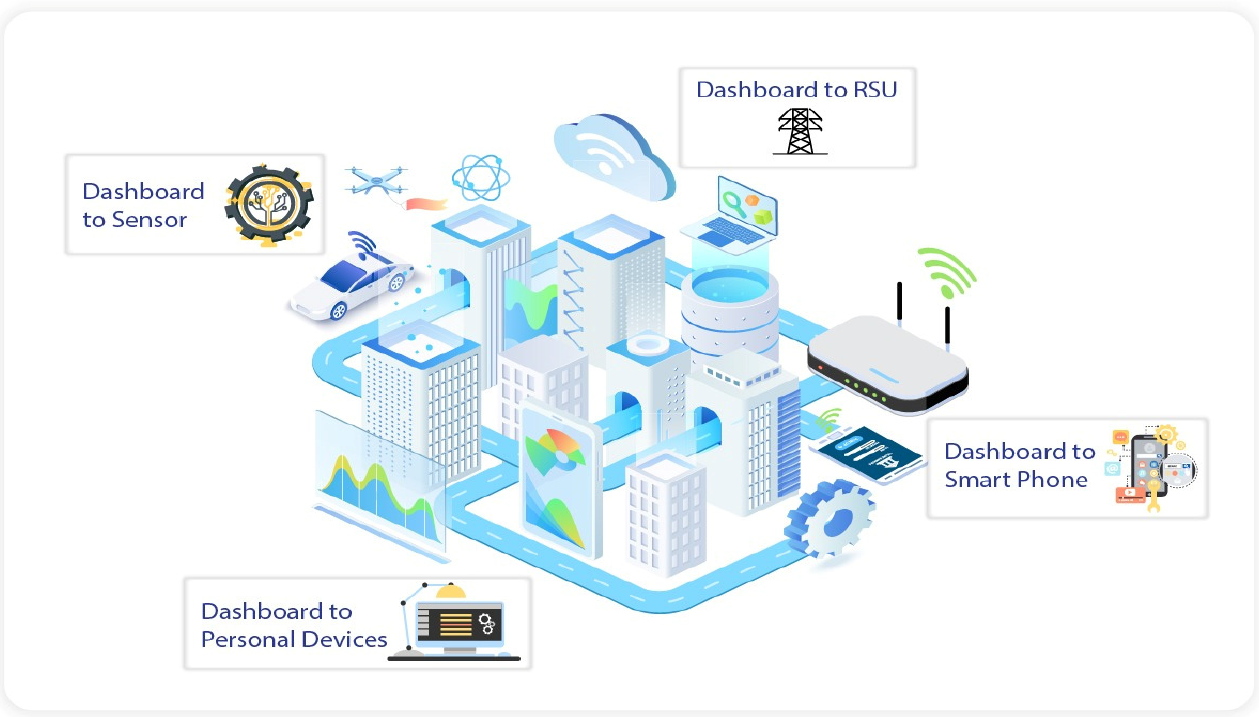
Figure 1. A smart city based on the IoT.